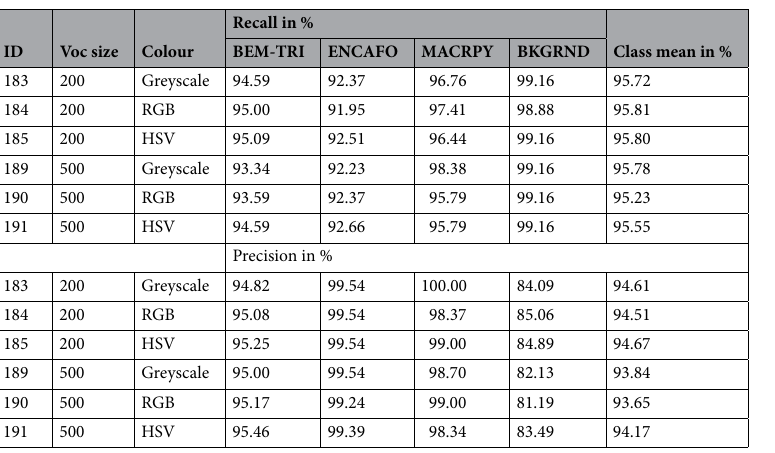
Table 4. Classification results after temporal and categorical pooling. The recall and precision of the different models trained considered the categorical pooling of BEMITA and TRIAVA and the temporal pooling of Lab0d and Lab7d. As previously described, the results for different dictionary sizes (vocsize) and colour spaces (colour) are compared.